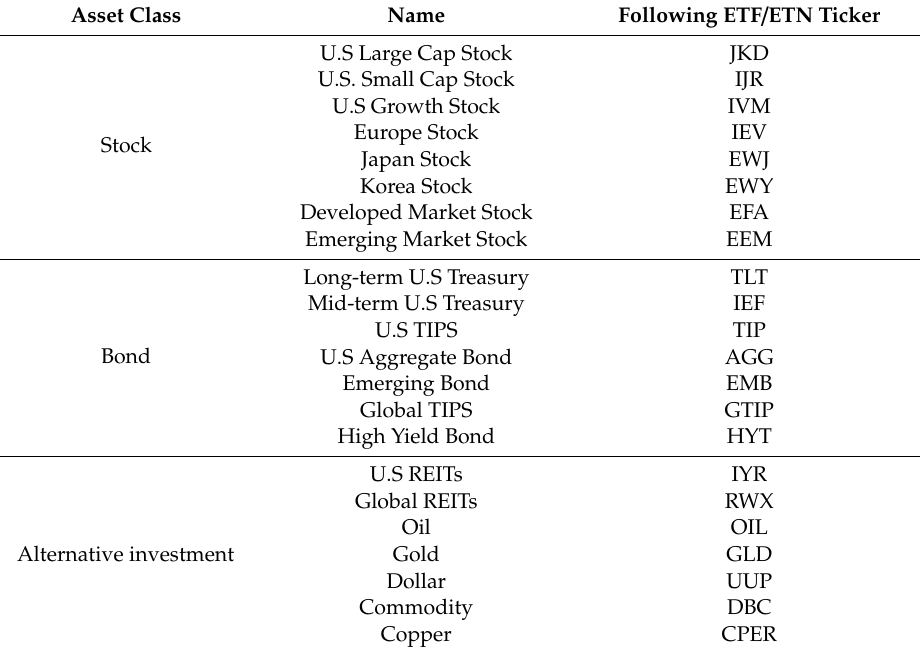
Table 3. Global Asset Allocation Invest Universe (Asset